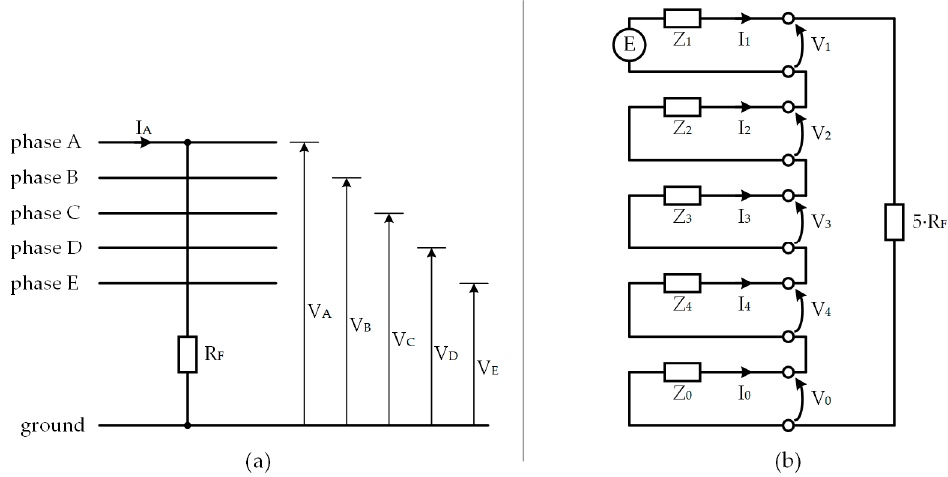
Figure 1. Ag fault: ( a ) the five-phase system and ( b ) sequence networks connections. Finally, the fault current I A is expressed in Equation (10) on the basis of the sequence networks diagram shown in Figure 1b.